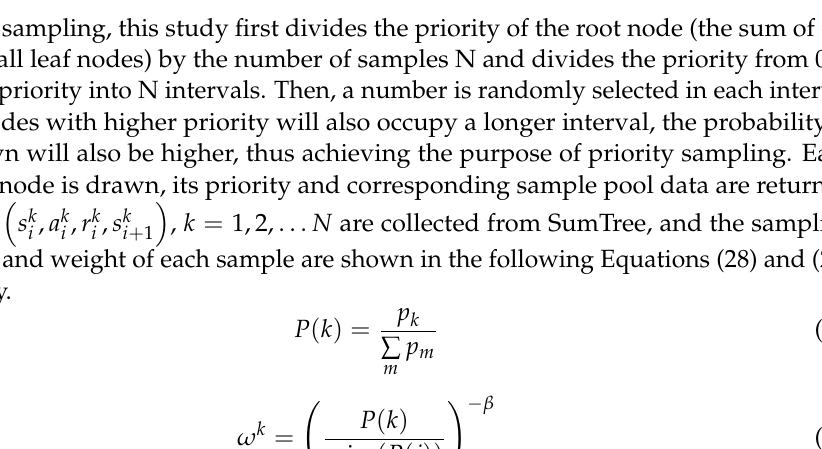
Figure 5. SumTree structure diagram.